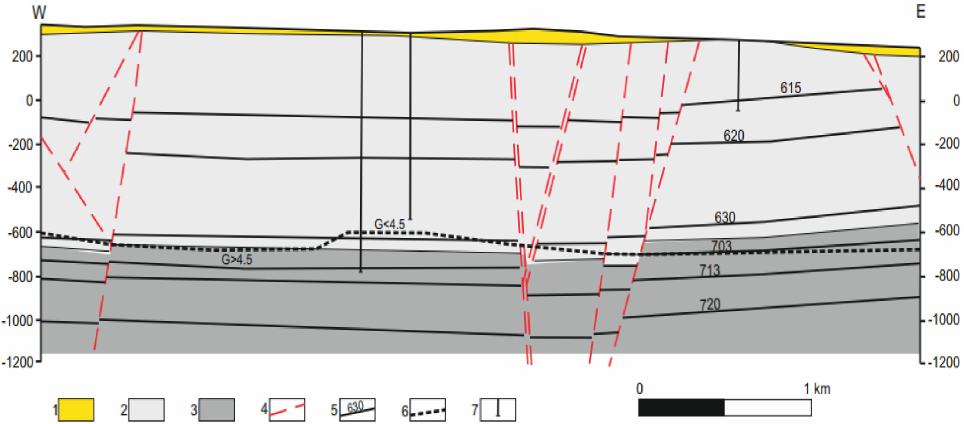
Figure 7. Cross-section across the Rydułtowy coal deposit (modified after Rydułtowy mine archive materials): 1—overburden, 2—Poruba layers, 3—Jaklovec layers, 4—fault, 5—coal seam, 6—top of the methane zone with G > 4.5 m 3 /t coal daf,